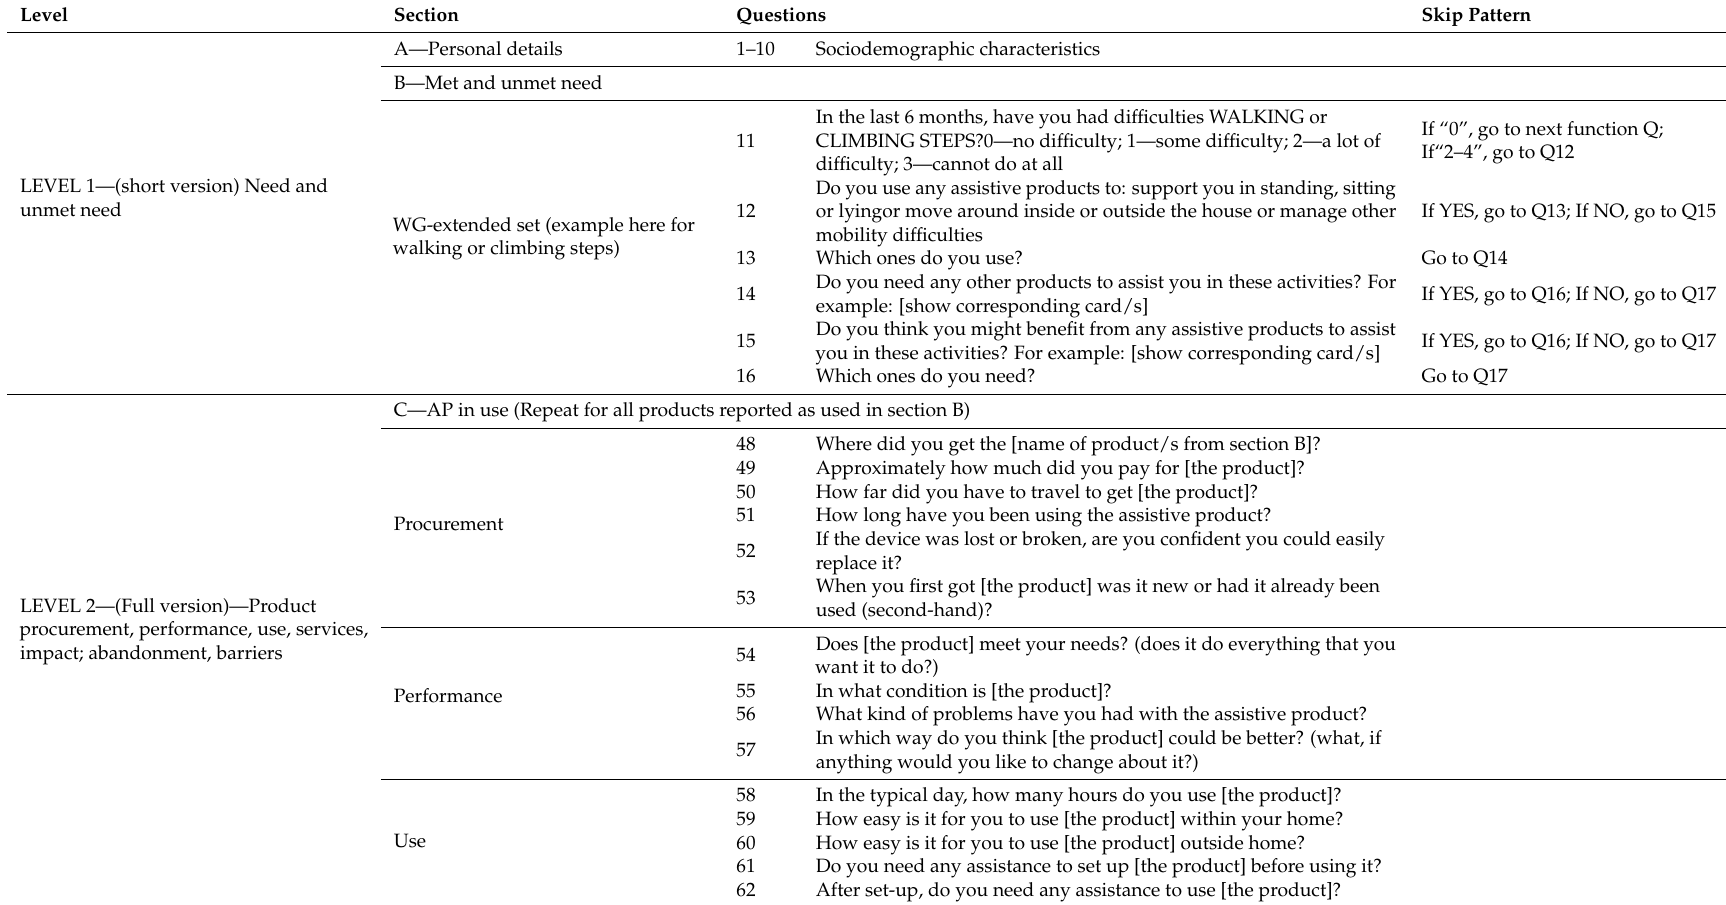
Table A1. Summary of WHO APA-Needs questions and skip logic as used adapted for use in the current